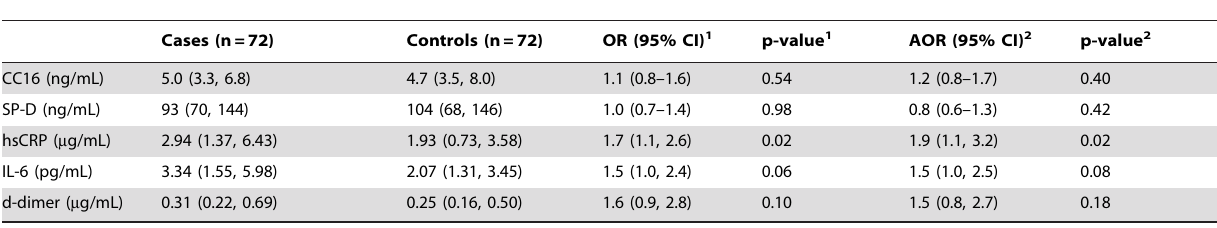
Table 4. Median (IQR) biomarker levels in cases and controls.